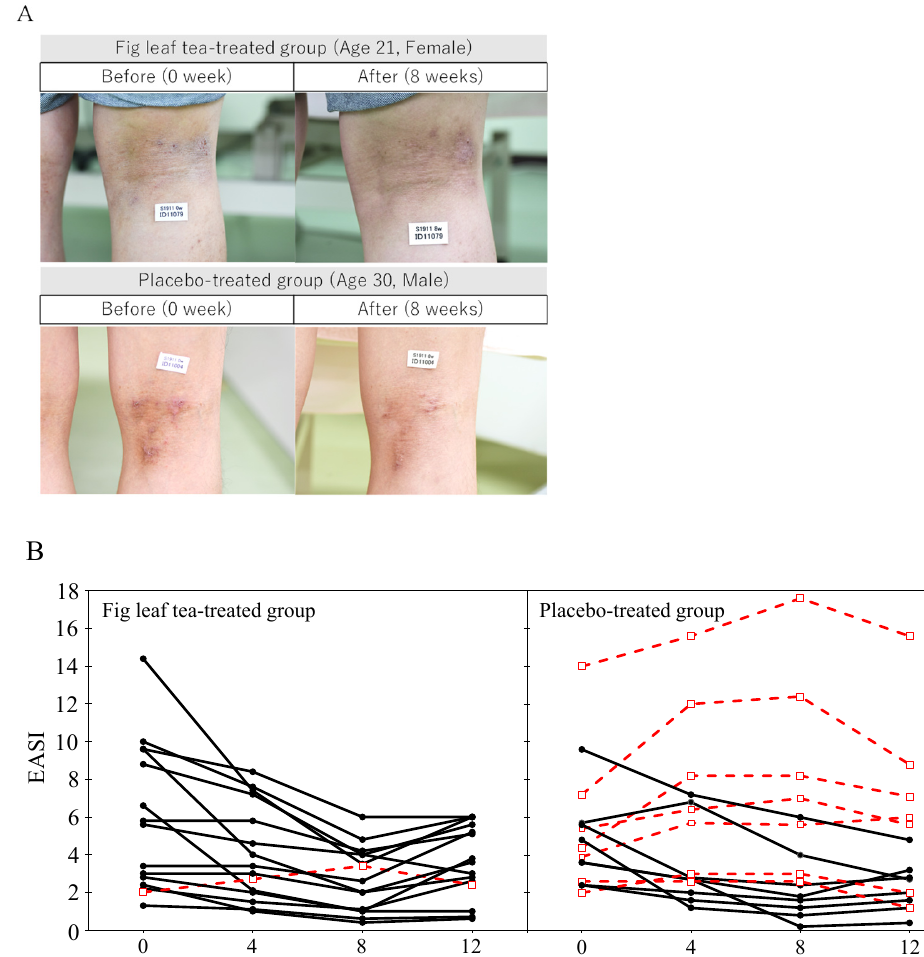
Figure 4. Changes in AD Symptoms and Individual EASI transitions. ( A ): Representative skin condition at 0 and 8 week in subjects from fig leaf tea and placebo group. ( B ): Changes in EASI per subject during the study period. Red dashed lines indicate subjects whose EASI at the end of intervention (8 weeks) was worse than before intervention (0 weeks).